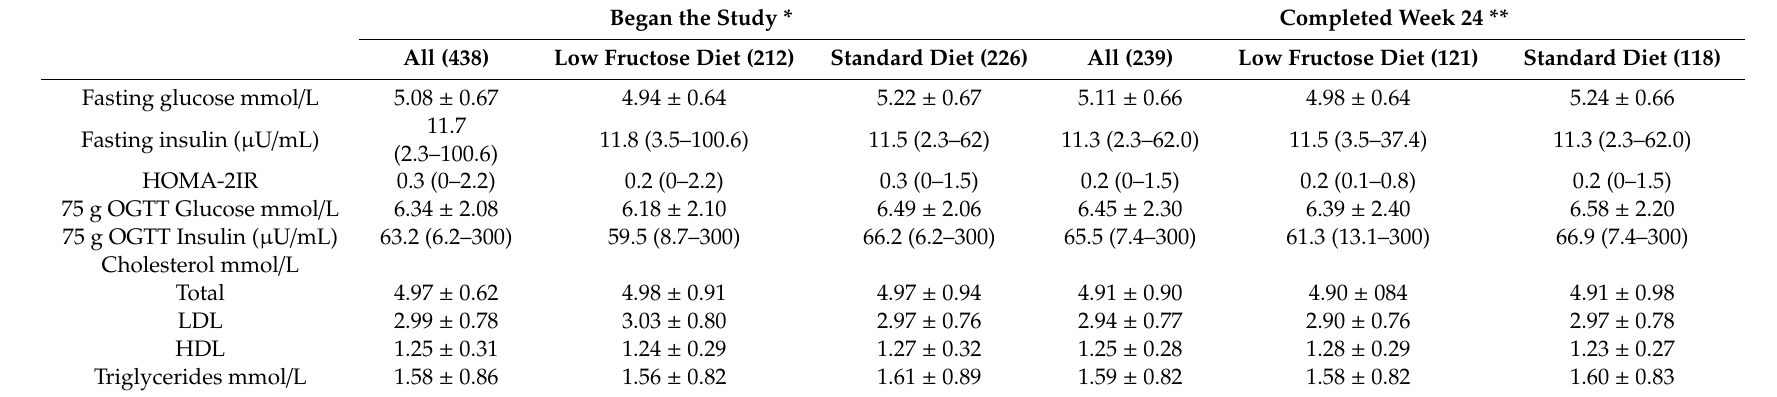
Table 2. Baseline Biochemical Variables of the Study